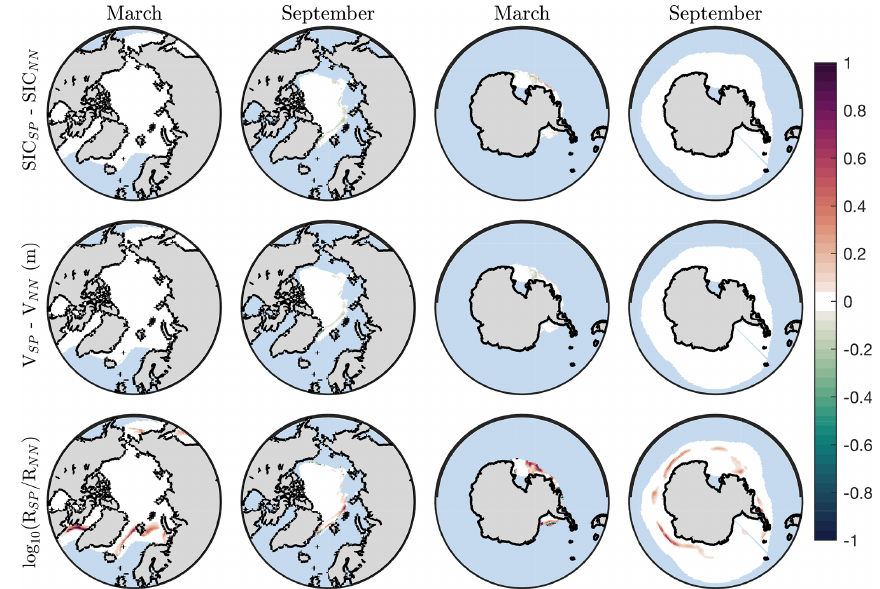
Figure 5. Implementation of WIFF in a climate model. Difference (top row) in monthly sea ice concentration, SIC, between SP-WIFF and NN-WIFF in March and September in each hemisphere. The middle row is the same as the top row for sea ice volume, V . The bottom row is the same for the log 10 ratio of the representative